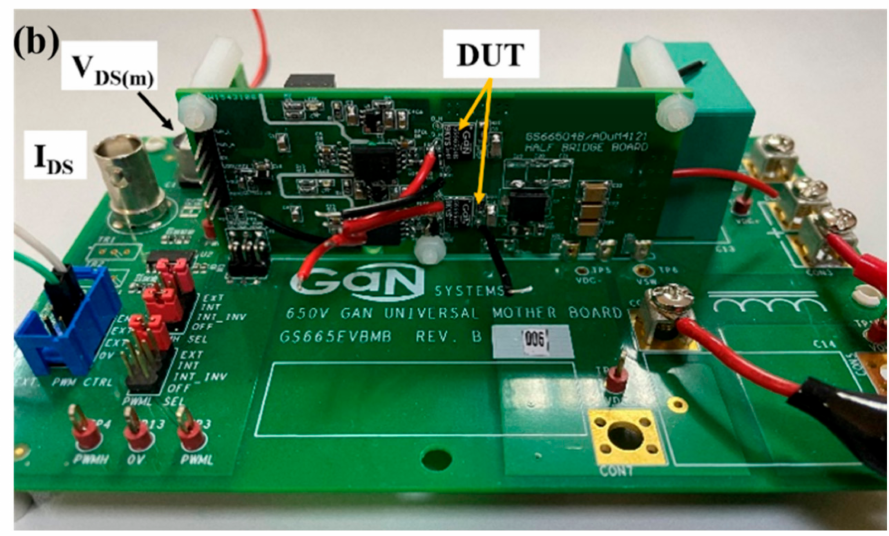
Figure 1. ( a ) Gallium nitride-high electron mobility transistor (GaN-HEMT) dynamic on-state resistance test circuit for hard-switching conditions with clamping circuit; ( b ) actual test board.